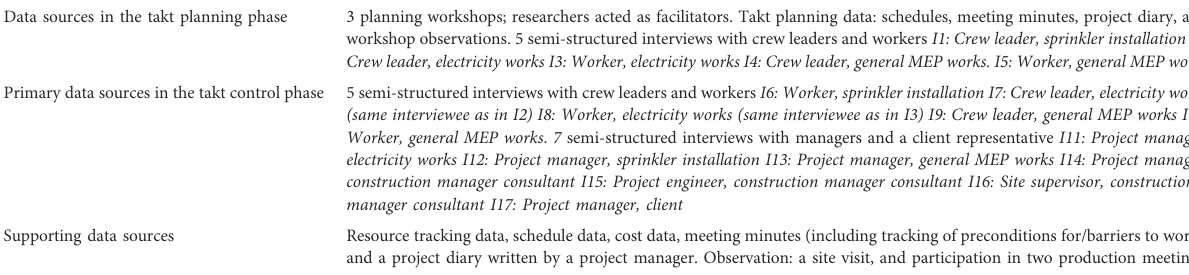
TABLE 1 Summary of the case study data sources. Data sources in the takt planning phase